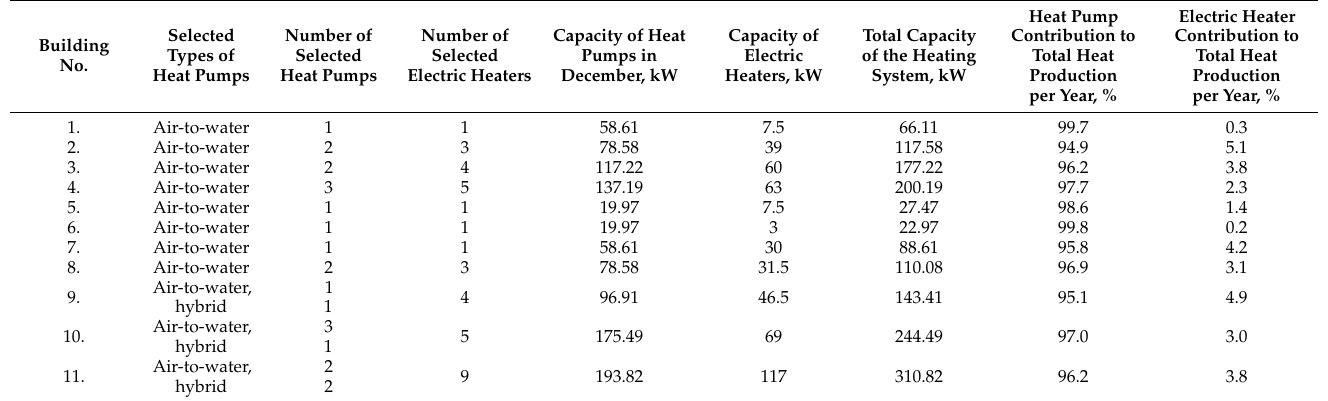
Table 2. Results for the optimal heating systems in different